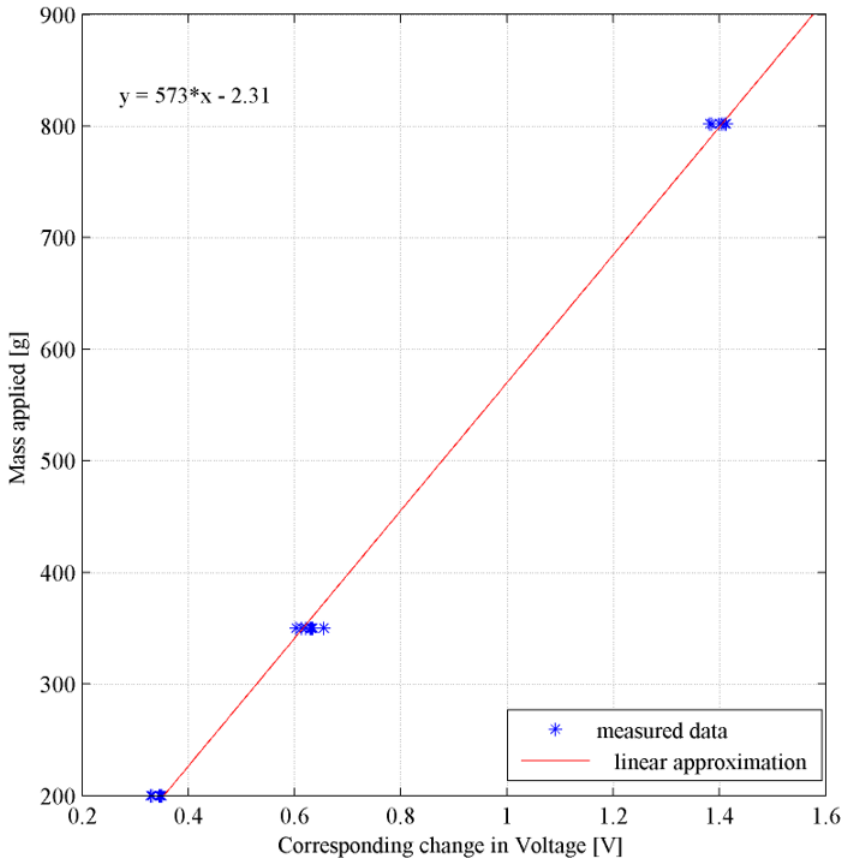
Figure 3. Relationship between measured voltage and test weight.